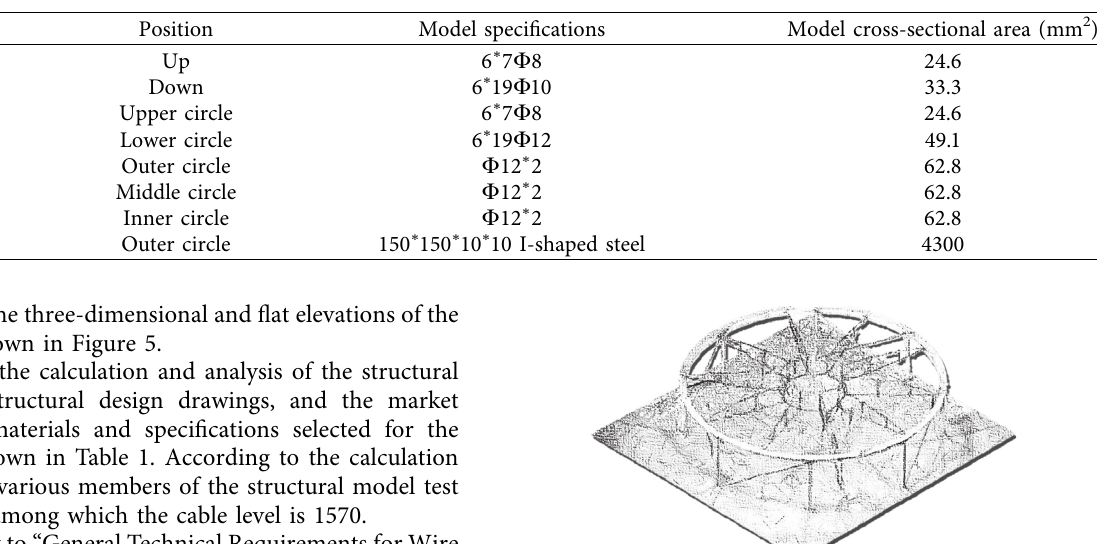
Table 1: Model material specification selection.